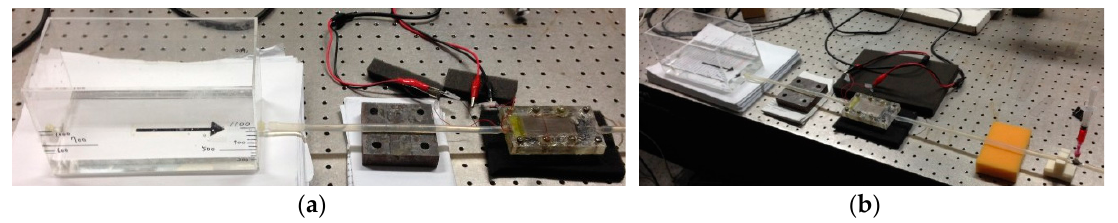
Figure 6. ( a ) The flow rate measurement set-up, and ( b ) the flow velocity measurement set-up of the pumping element.